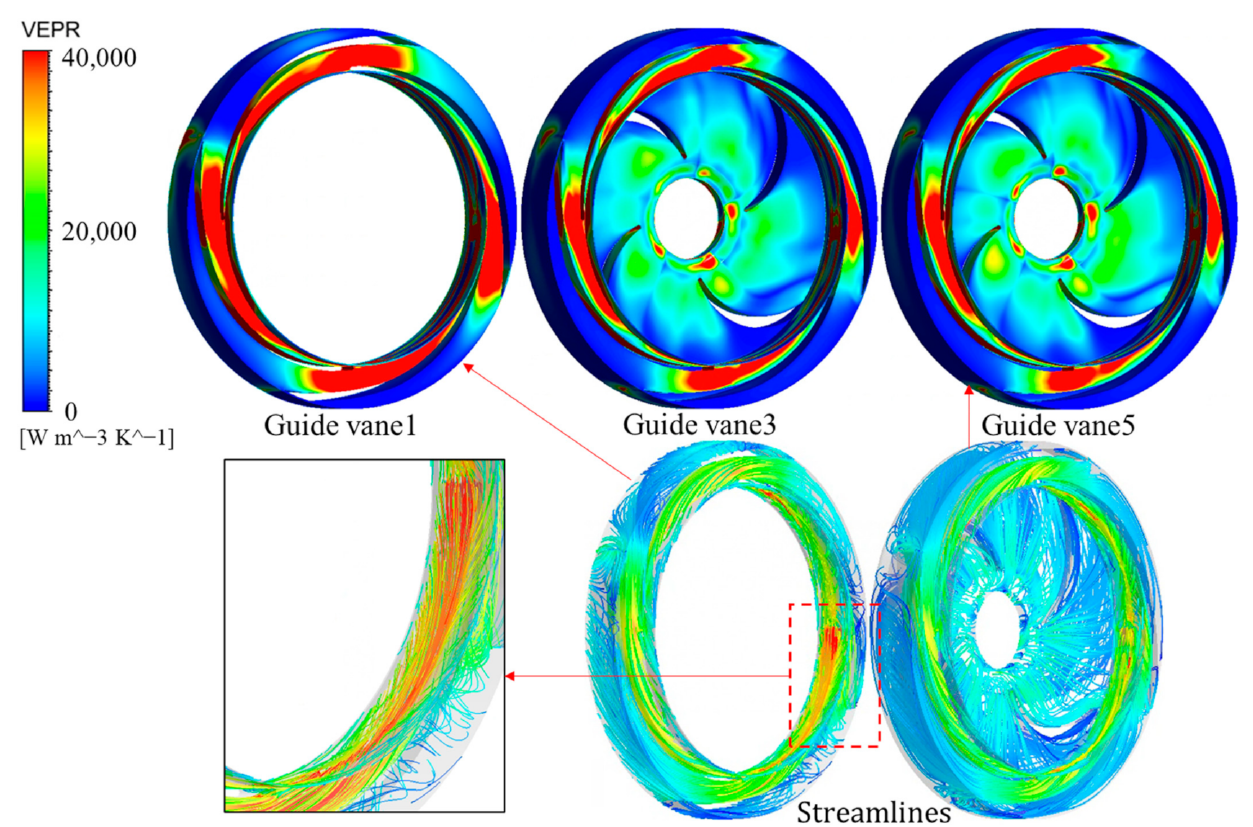
Figure 17. Contour of the VEPR and streamlines at guide